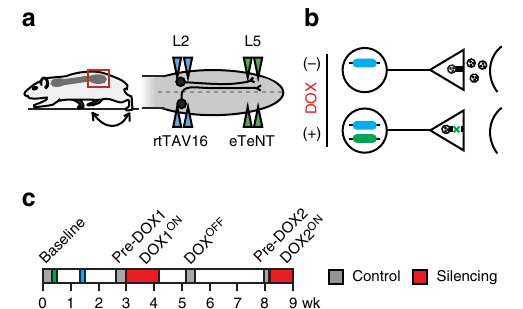
Fig. 1 Experimental design to conditionally silence L2 – L5 interneurons in the freely behaving adult rat. a In the lumbar spinal cord, L2 neurons with ipsilateral or contralateral projections to L5 were targeted for conditional silencing. Bilateral injections of AAV2-CMV-rtTAV16 (blue triangles) and HiRet-TRE-EGFP.eTeNT (green) were performed at L2 and L5, respectively. b In the presence of doxycycline (DOX), only double-infected neurons conditionally express eTeNT (adapted from Kinoshita et al. 9 ). eTeNT is transported to the terminal fi eld where it prevents synaptic vesicle release thereby silencing neurotransmission. c Behavioral assessments were performed at four control time points (Baseline, BL; Pre-DOX1, PD1; DOX OFF ; Pre-DOX2, PD2) and during two rounds of DOX ON silencing separated by a 1-month washout (DOX1 ON days 3, 5, 8 and DOX2 ON days 3 and 5). Illustrations by A.